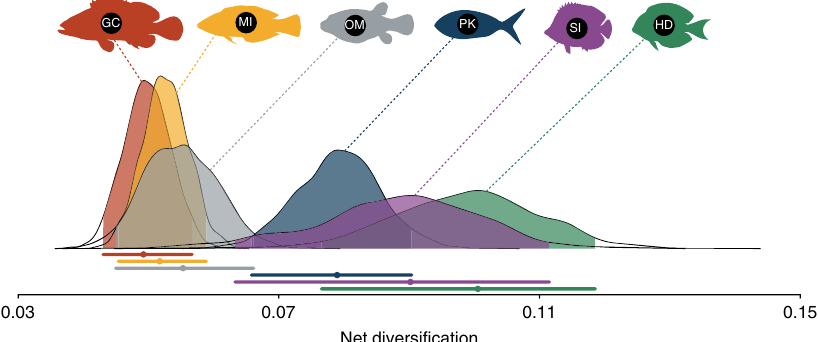
Fig. 4 Historical net diversi fi cation rate estimates for six reef fi sh trophic groups. Lines below the distributions show mode values (solid circles) with respective 95% credibility intervals. Rates represent the values estimated with MuSSE for 100 trees. HD: herbivores/detritivores (green); SI: sessile invertivores (purple); OM: omnivores (gray); PK: planktivores (blue); MI: mobile invertivores (yellow); GC: generalized carnivores (red). Fish silhouettes were sourced from Schiettekatte et al. 91 . Source data is provided as a Source Data fi le.